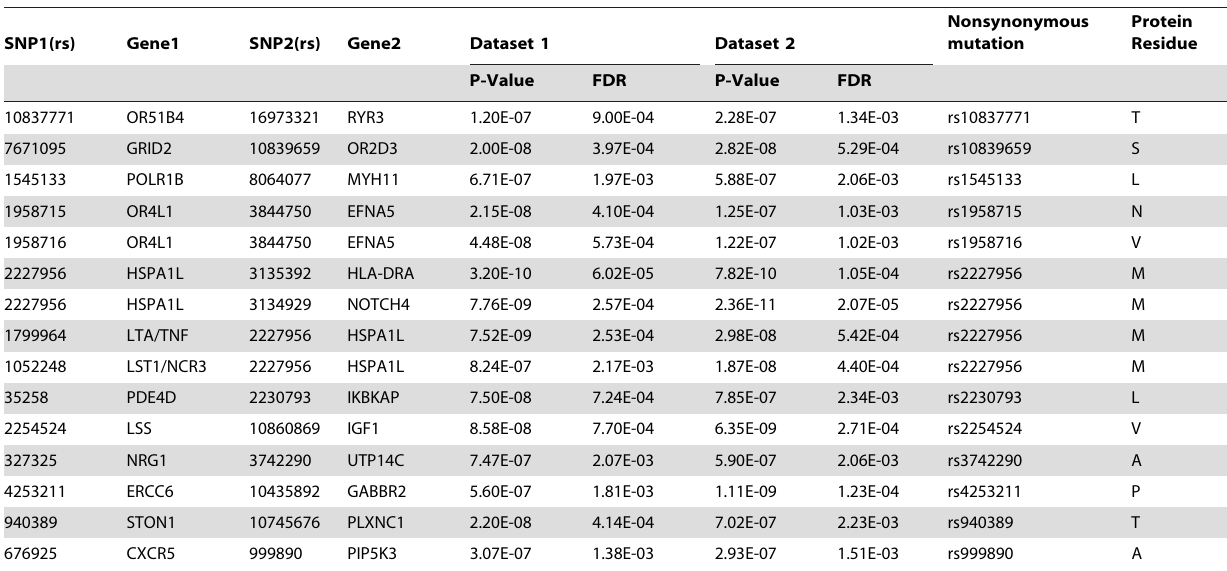
Table 4. Interacting SNPs with non-synonymous